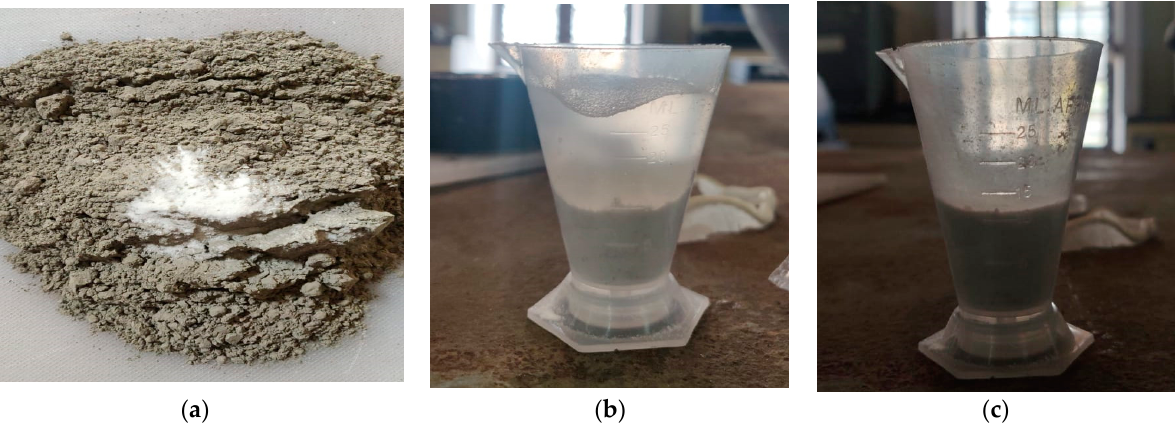
Figure 1. ( a ) Blended cement mix; ( b ) SAP before water absorption; ( c ) SAP after water absorption.